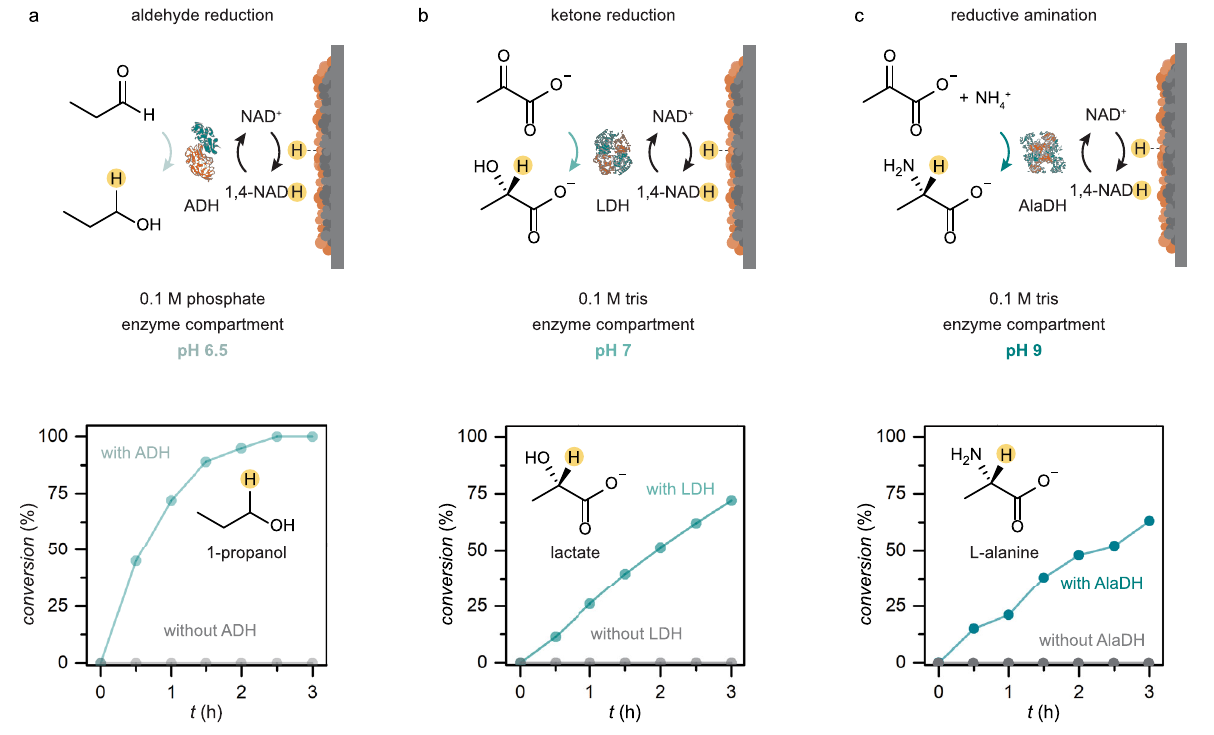
Fig. 4 | Performance of enzymatic reactions in the BioPMR at pH 6.5, 7, and 9. a Reduction of propionic aldehyde with alcohol dehydrogenase (ADH) in phos- phate buffer at pH 6.5. b Reduction of pyruvic acid with lactate dehydrogenase